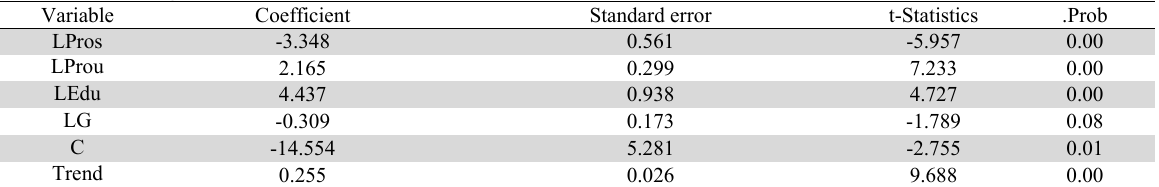
Investigating the long-run relationship between the productivity of skilled and unskilled workers and the level of wages with trends Variable Coefficient